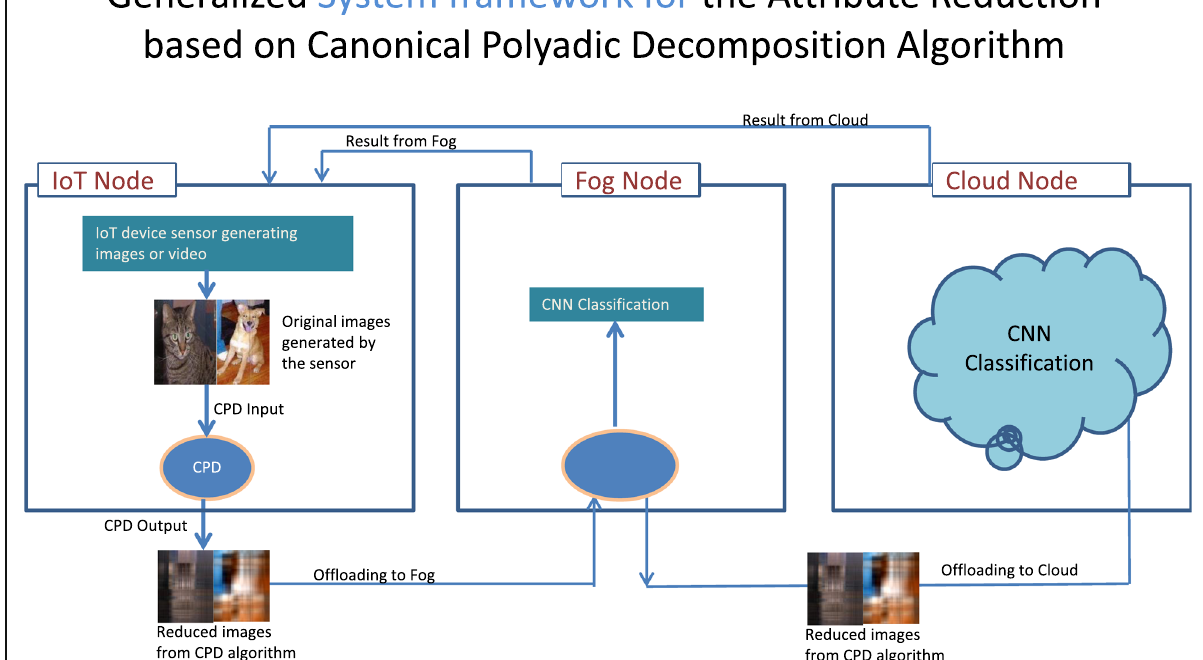
Fig. 1 Generalized System framework for the Attribute Reduction based on Canonical Polyadic Decomposition Algorithm. Note: CPD (canonical Polyadic Decomposition), CNN (convolutional Neural